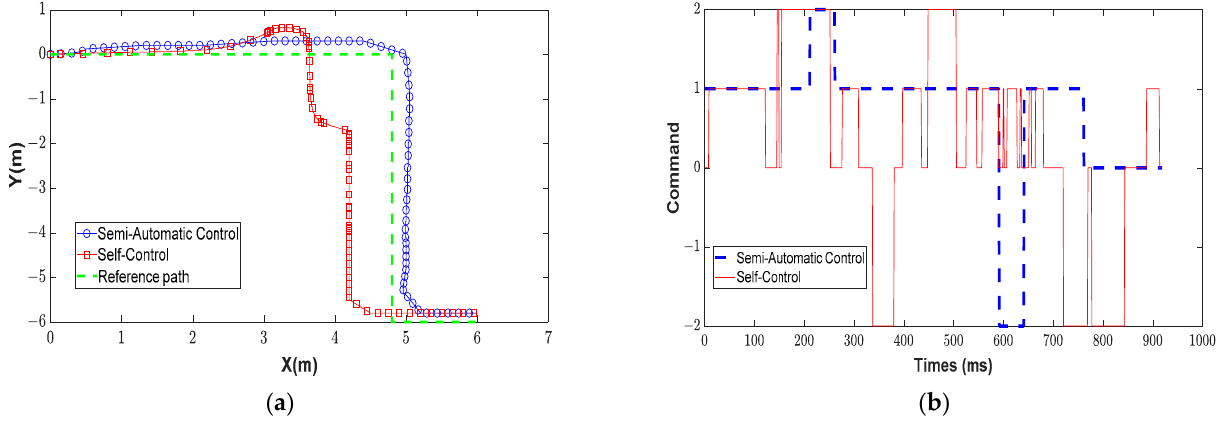
Figure 15. The comparison of the stable movements of the wheelchair in two control methods (semi ‐ automatic control and self ‐ control). ( a ) The real paths of the two control methods and the reference automatic control and self-control). ( a ) The real paths of the two control methods and the reference path; ( b ) the control sequences of the two control methods. path; ( b ) the control sequences of the two control